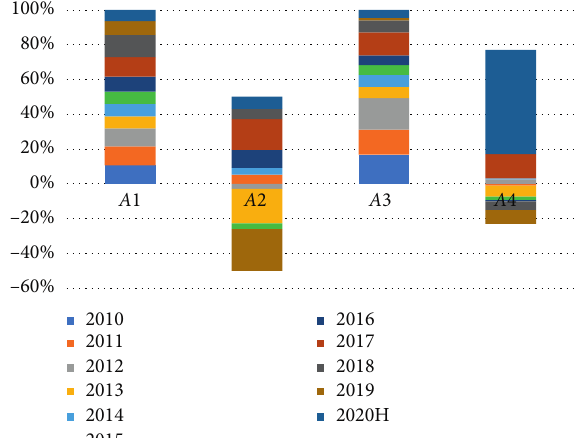
Figure 4: The circulation of money leads to the redistribution of the amount of money in the real